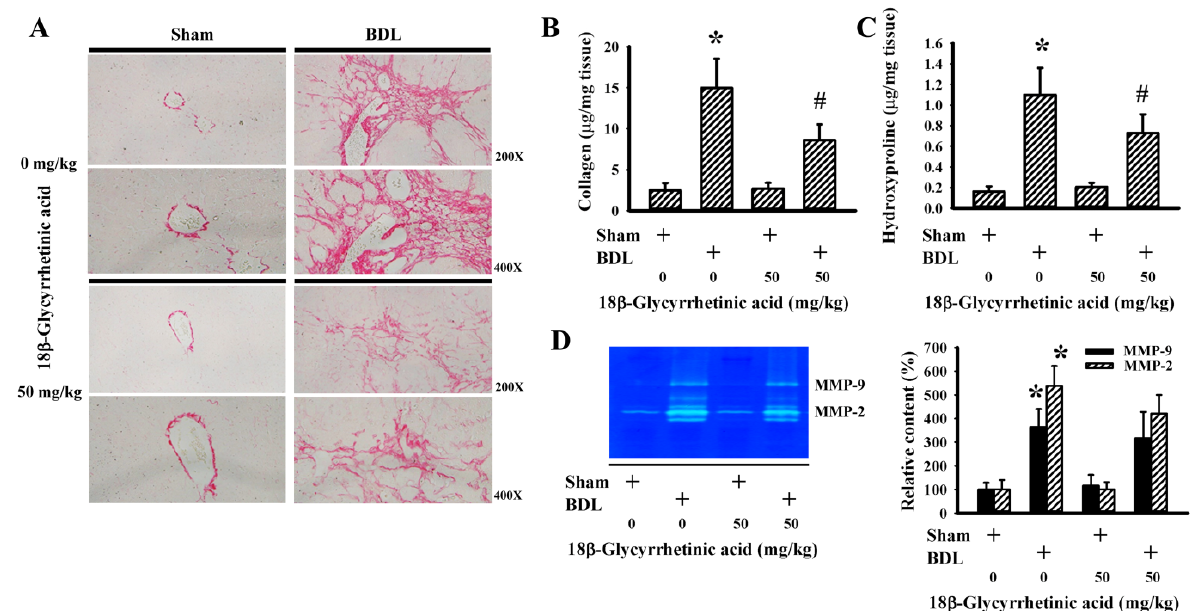
Figure 5. 18 β -Glycyrrhetinic acid alleviated BDL-induced hepatic collagen deposition in treatment study. ( A ) The paraffin-embedded liver tissues were subjected to Sirius Red staining. Representative photomicrographs are shown. Original magnification is 200 × and 400 × . ( B ) Collagen contents in liver tissues were measured. ( C ) Hydroxyproline contents in liver tissues were measured. ( D ) MMP-2 and MMP-9 activities of proteins isolated from liver tissues were measured using zymographic assay. Representative zymographs and the quantitative data are shown. * p < 0.05 vs. the sham vehicle group and # p < 0.05 vs. the BDL vehicle group, n = 8.